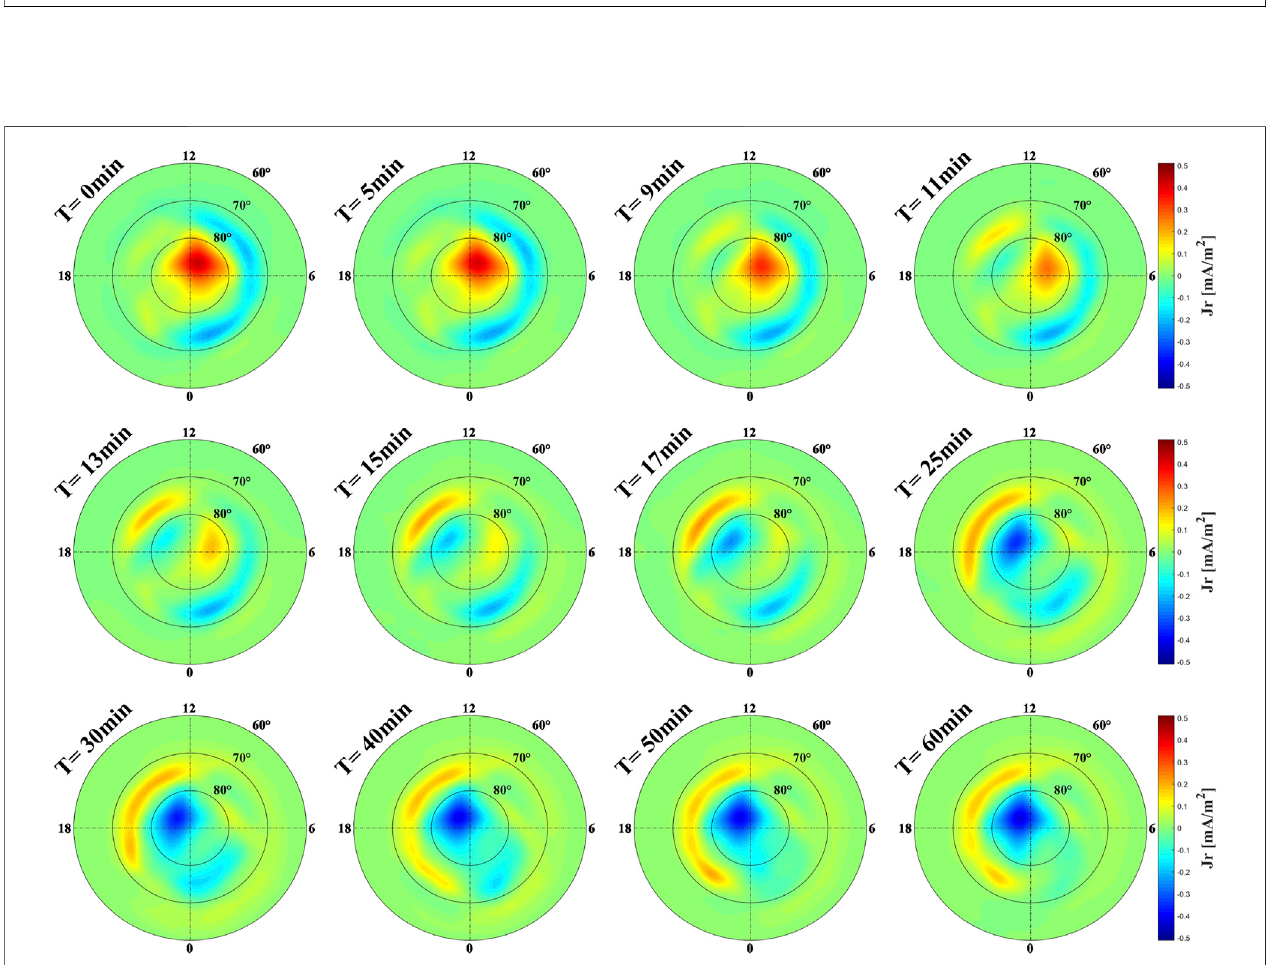
FIGURE 2 | Ionospheric FACs pattern in the northern hemisphere. Red indicates upward current and blue indicates downward current.